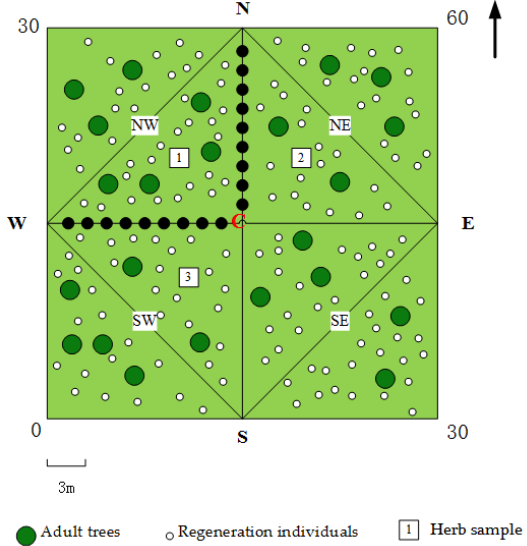
Figure 1. The distribution of the regeneration individuals of each sampling plot. Abbreviations: C = center; N = northern transition; E = eastern transition; S = southern transition; W = western transition; NE = northeast; SE = southeast; NW = northwest; SW = southwest.